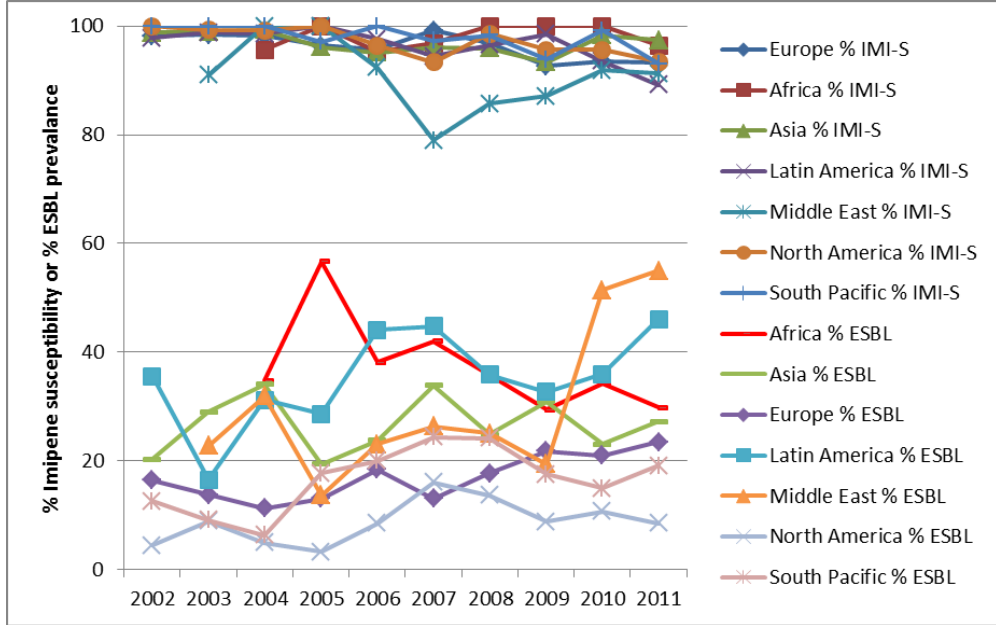
Figure 5. Susceptibility of K. pneumoniae from intra-abdominal infections to imipenem (IMI-S) and prevalence of ESBLs by region from SMART 2002 to 2011.